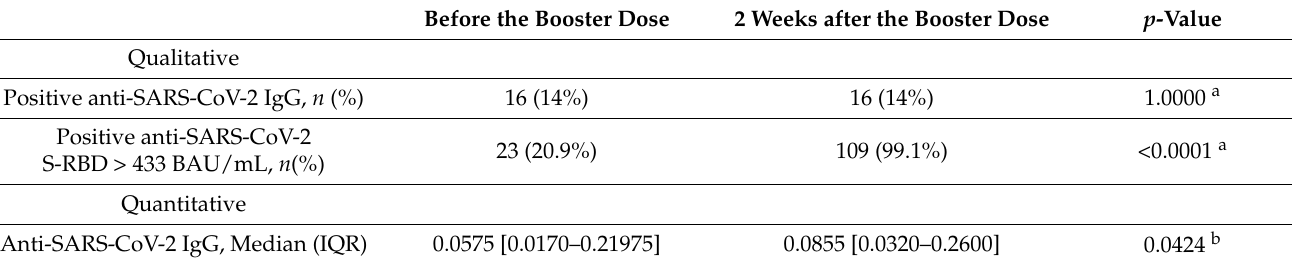
Table 2. SARS-CoV-2 serological tests among HCWs from the Hospital for Infectious Diseases (Warsaw, Poland) before and after the booster dose of the BNT162b2 (Comirnaty) vaccine. Before the Booster Dose 2 Weeks after the Booster Dose